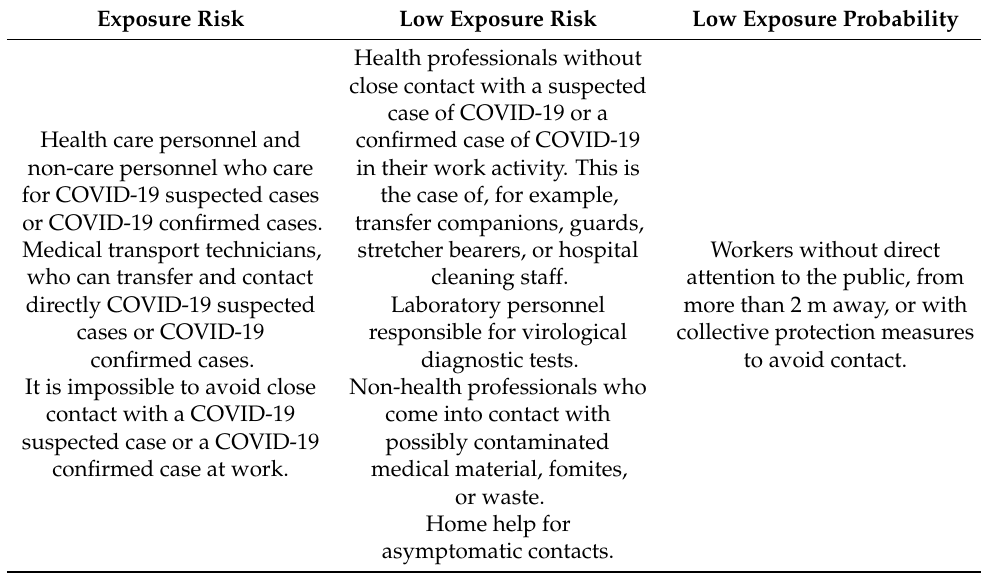
Table 1. Exposure risk degrees to SARS-CoV-2 coronavirus in the work environment [12].